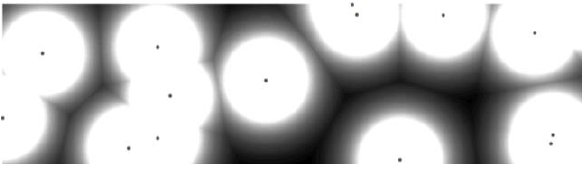
Figure 4. Fuzzy Distance